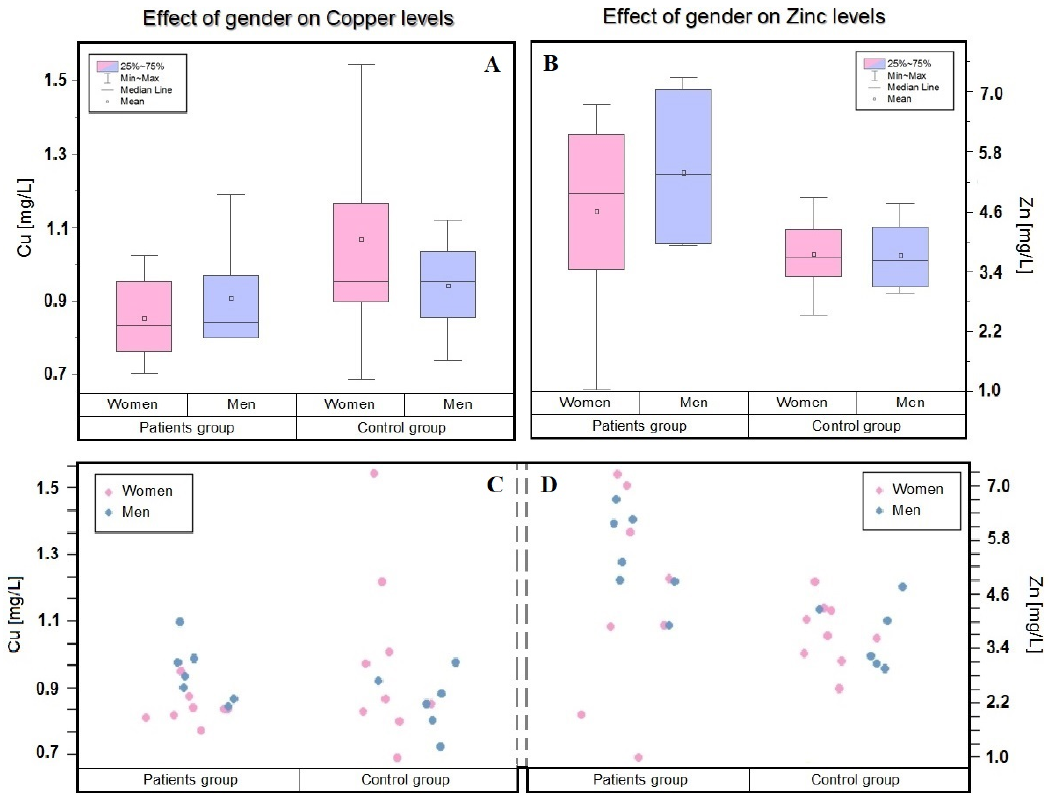
Figure 1. Dependence of the concentration of zinc and copper in the blood of patients and the control group depending on the selected criterion—gender (In patient group: women—pink; n = 8, men—blue; n = 7. In control group women— pink; n = 9, men—blue; n = 6). The mean (circle), median (line), percentile 25, 75 (boxes), and minimum and maximum value (whiskers) are shown in ( A , B ). ( A ) Box plot showing the influence of gender on the concentration of copper. ( B ) Box plot showing the influence of gender on the concentration of zinc. The visualizations in ( C , D ) were inspired by the t -test, i.e., they are an attempt to compare the means of two finite research samples with selected criteria. ( C ) Shows visualiza- tions of the distribution of copper concentrations considering the gender criterion. ( D ) Shows visualizations of the distri- bution of zinc concentrations considering the gender criterion.